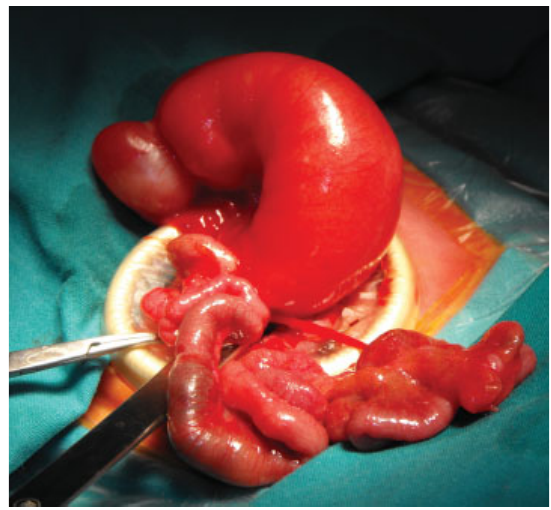
Fig. 1 Case of high jejunal atresia and distal apple peel deformity.